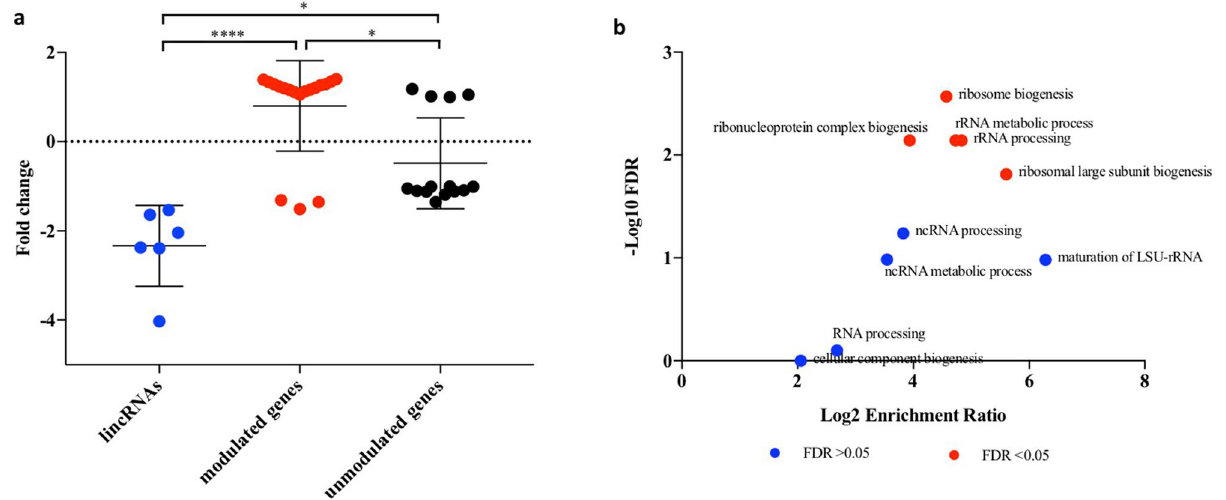
Figure 7. Expression and biological processes of genes within the co-expression network of DElincRNAs in the generation F 1 of embryos (5.5 hpf) from parents exposed to 8.7 mGy/h γ-radiation (F 1 -γ). Gene expression values from our parallel differential expression data (GSE98539) 9 . ( A ) DElincRNAs expression level compared to modulated and unmodulated genes within the co-expression network. Modulated genes represent differentially expressed (FDR < 0.05), unmodulated genes represent not differentially expressed (FDR > 0.05). Asterisks indicate significant differences (**** p < 0.0001, * p < 0.05, Kruskal–Wallis and Dunn’s multiple comparison test, n = 3). ( B ) Overrepresented GO terms under the category biological processes from modulated genes in A (FDR < 0.05